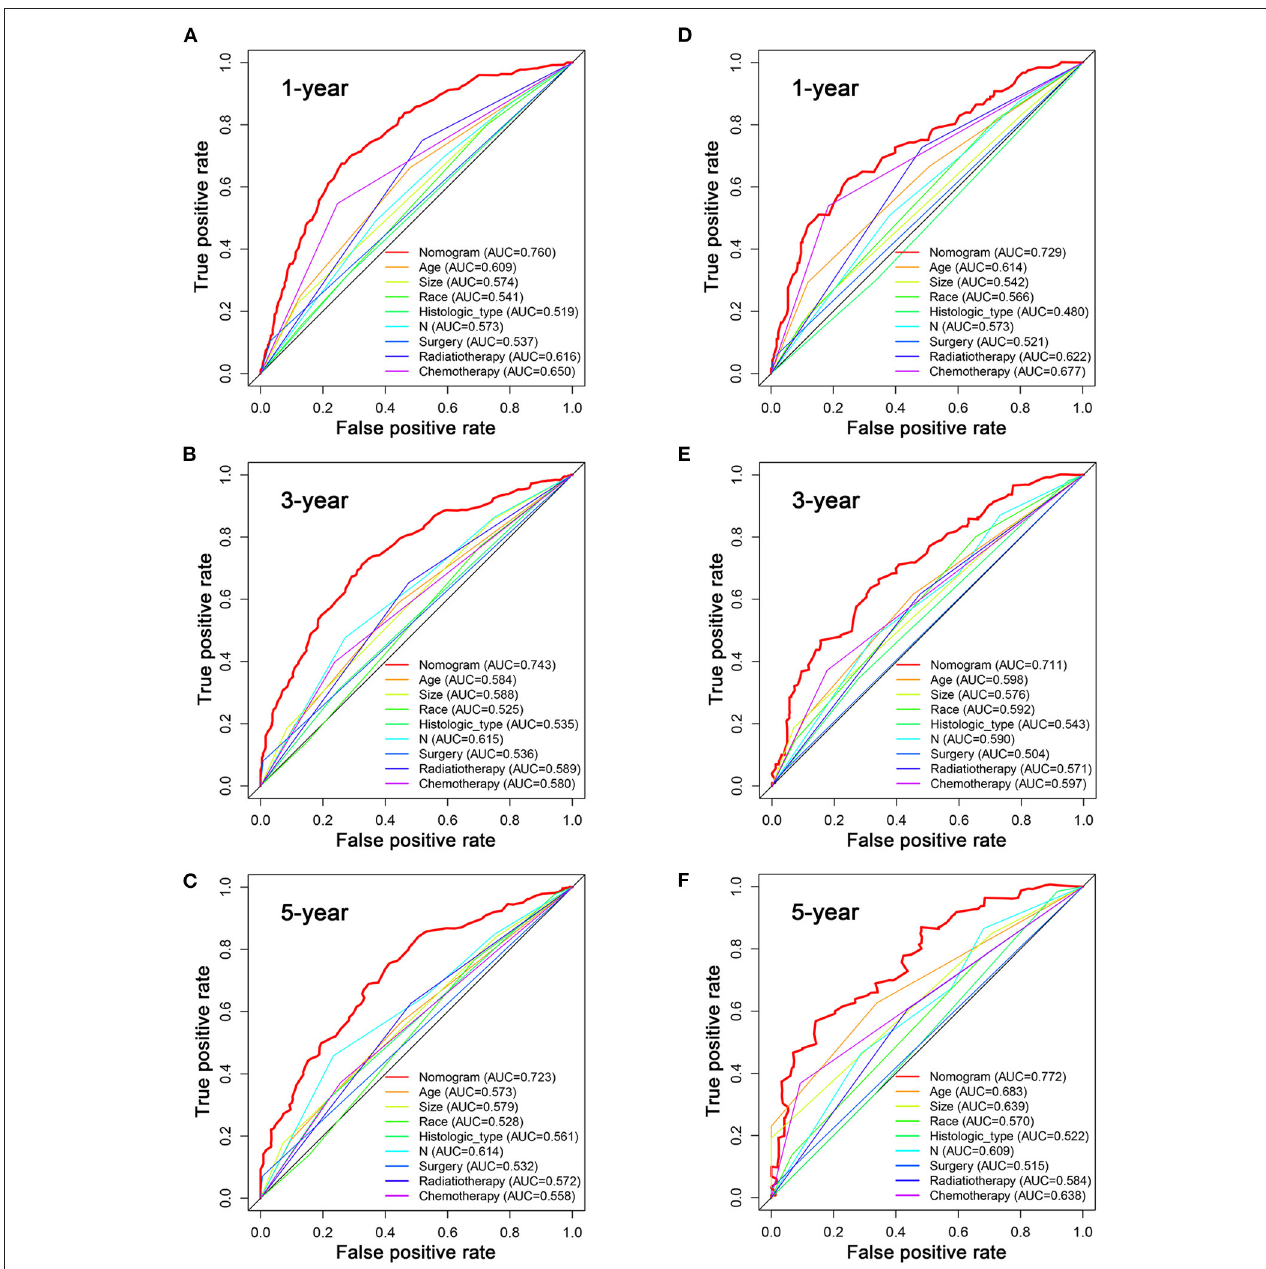
FIGURE 3 | The ROC curves for predicting patients’ OS of nomogram and all independent predictors at 1 (A) , 3 (B) , and 5 years (C) in the training cohort and at 1 (D) , 3 (E) , and 5 years (F) in the validation